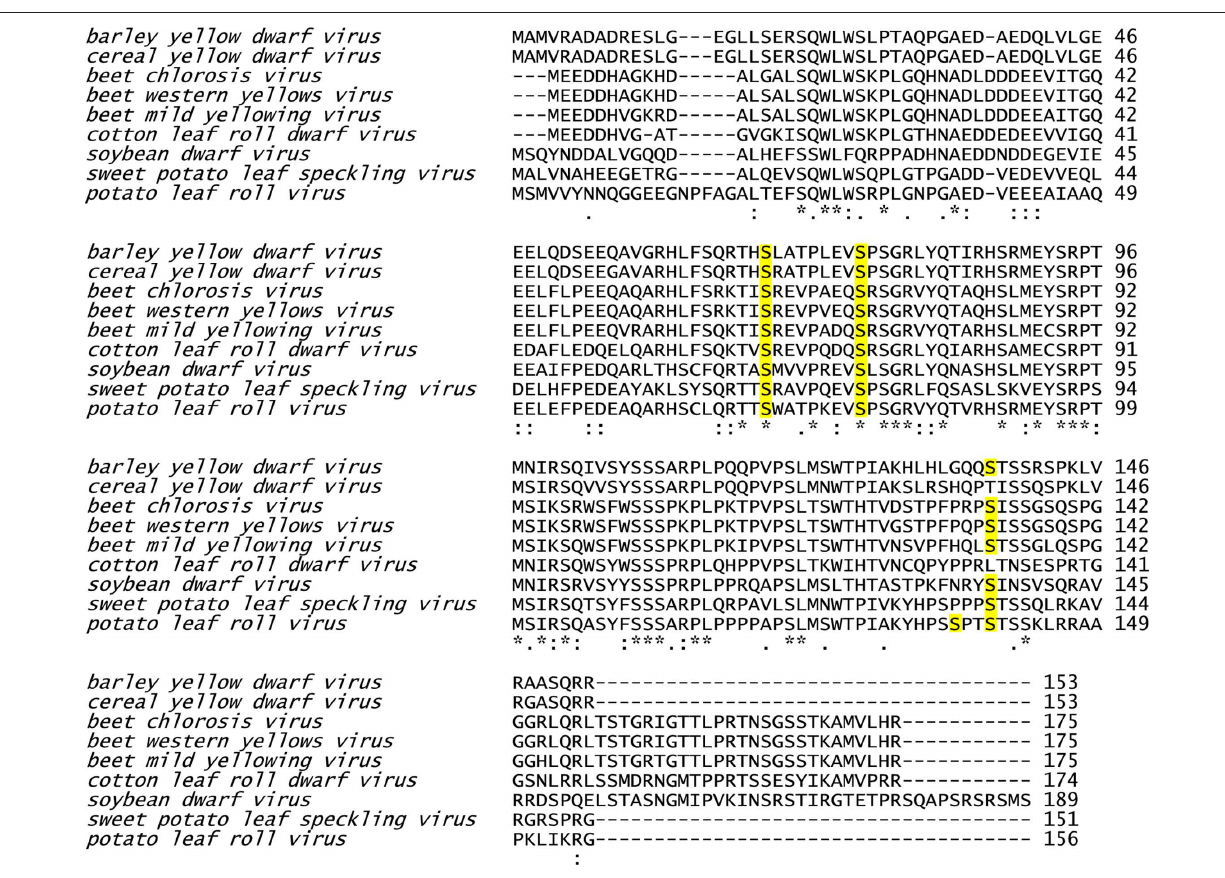
FiguRe 8 | Sequence alignment of MPs of different luteoviruses. Phosphorylation sites identified in PLRV–MP17 are highlighted in yellow. potential chloroplast transit peptides at the N-terminus of 4002